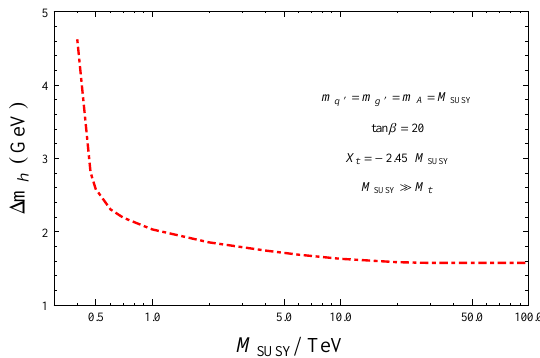
Figure 5. Estimation of the theory uncertainty of the Higgs mass produced with FeynHiggs in the hybrid approach for an MSSM scenario with degenerate SUSY masses.